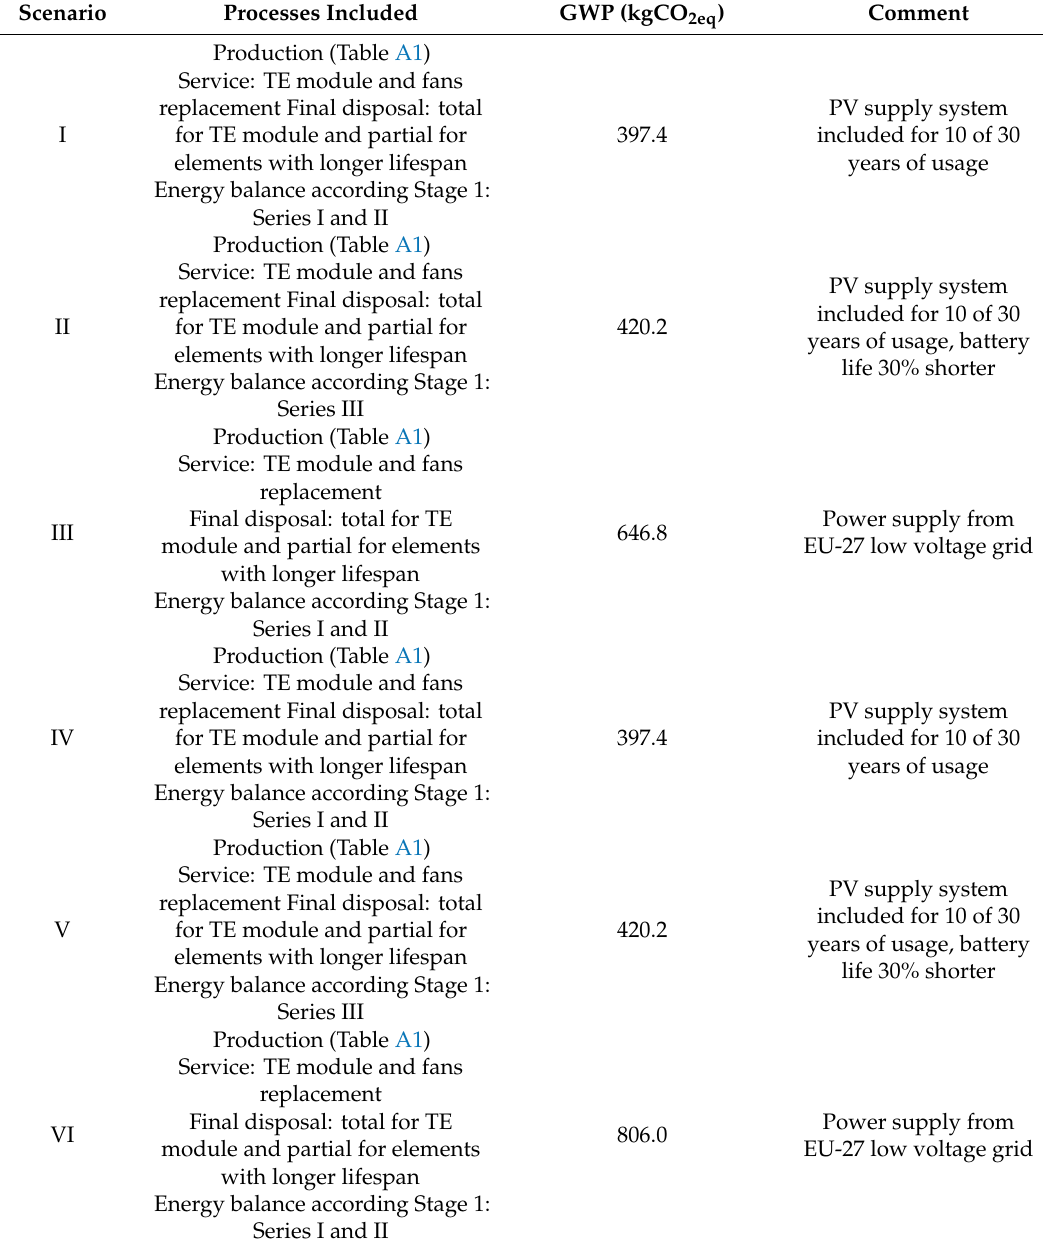
Table A3. Assumptions for LCA and GWP (total) of TE cooling system applied in Stage